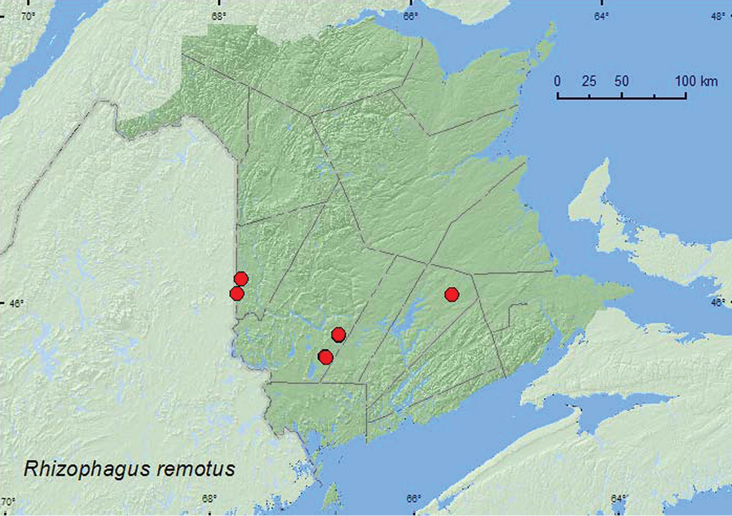
Collection localities in New Brunswick, Canada of Rhizophagus remotus.